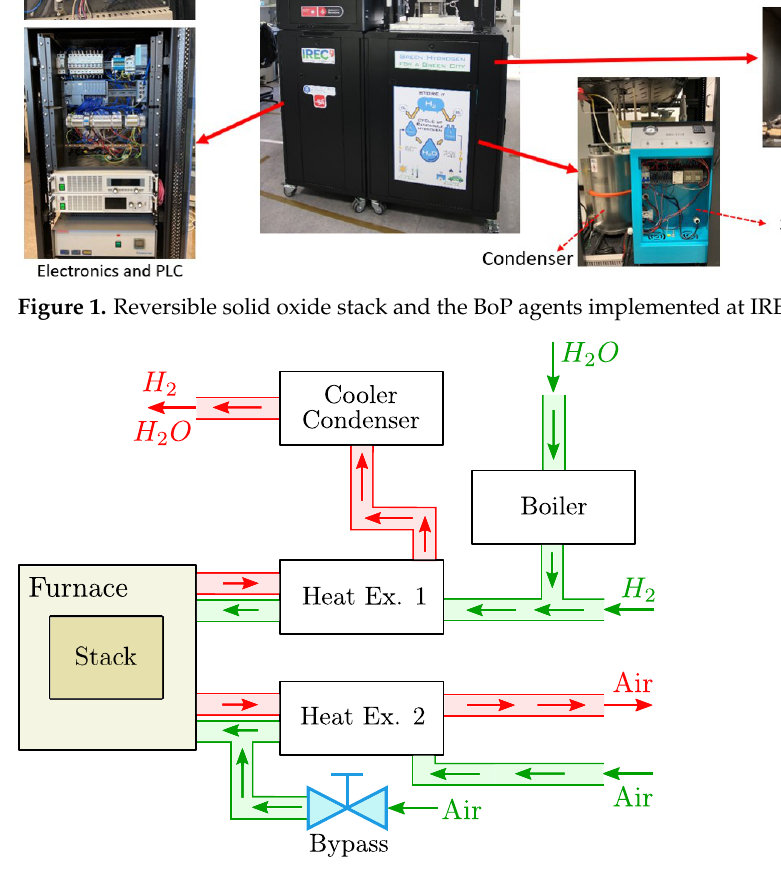
Figure 2. A schematic illustration of the IREC solid oxide station operation including the balance of plant agents. The red channels denote the outlet flows, while the green channels denote the inlet